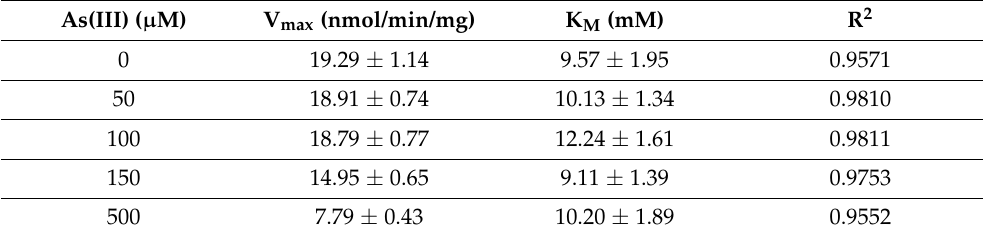
Table 2. Kinetics parameters, V max and K M , of the Tt ArsC phosphatase activity and respective R 2 values for nonlinear regression fitting at different As(III) concentrations.